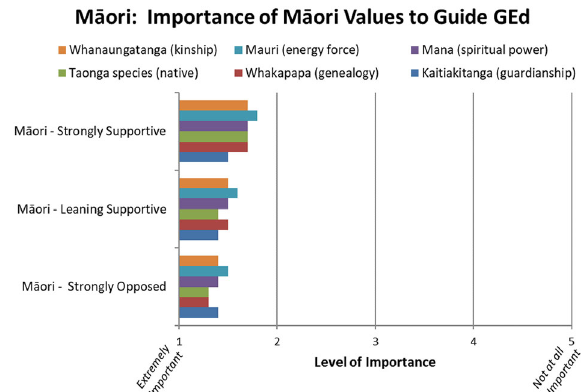
Fig. 6 Support for M ā ori values in guiding decisions about GEd among M ā ori respondents byclusters. M ā ori respondents in all cluster perspectives – Strongly Supportive, Leaning Supportive, and Opposed – believe that M ā ori values are important in guiding decisions about the use of GEd. The M ā ori value of Whanaungatanga (kinship) is shown in orange, Mauri (life force) light blue, Mana (spiritual power) purple; Taonga species (native species) green, Whakapapa (genealogy) red, and Kaitiakitanga (guardianship) dark